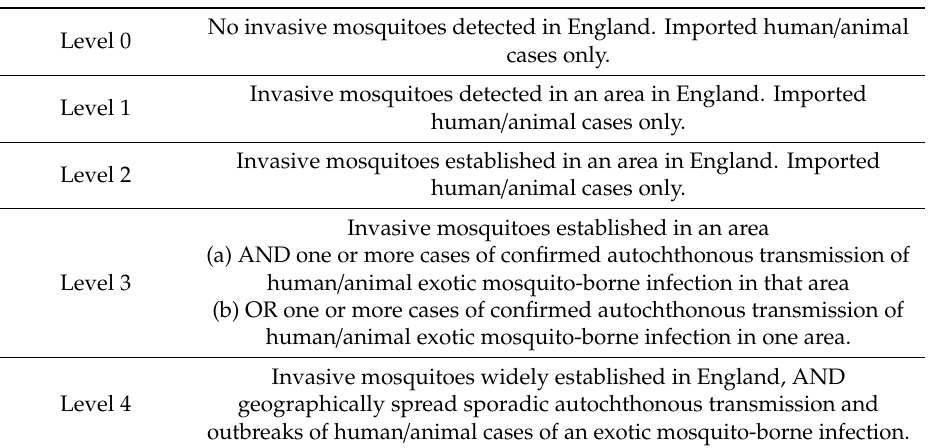
Table 2. Levels of risk for invasive mosquito species and / or indigenous exotic vector-borne disease transmission (Levels 2 to 4 shown for information only). Taken from the National Contingency Plan for Invasive Mosquitoes . No invasive mosquitoes detected in England. Imported human / animal Level 0 cases only. Invasive mosquitoes detected in an area in England. Imported Level 1 human / animal cases only. Invasive mosquitoes established in an area in England. Imported Level 2 human / animal cases only.